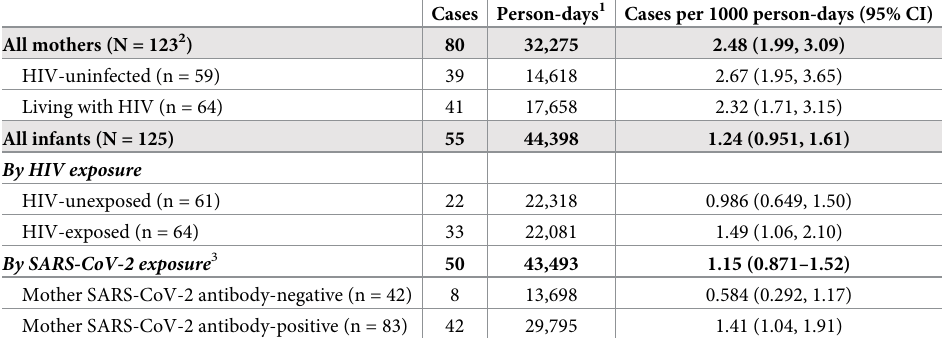
Table 2. Incidence of SARS-CoV-2 infection in postpartum Kenyan women and their infants from May 1, 2020 to February 1,